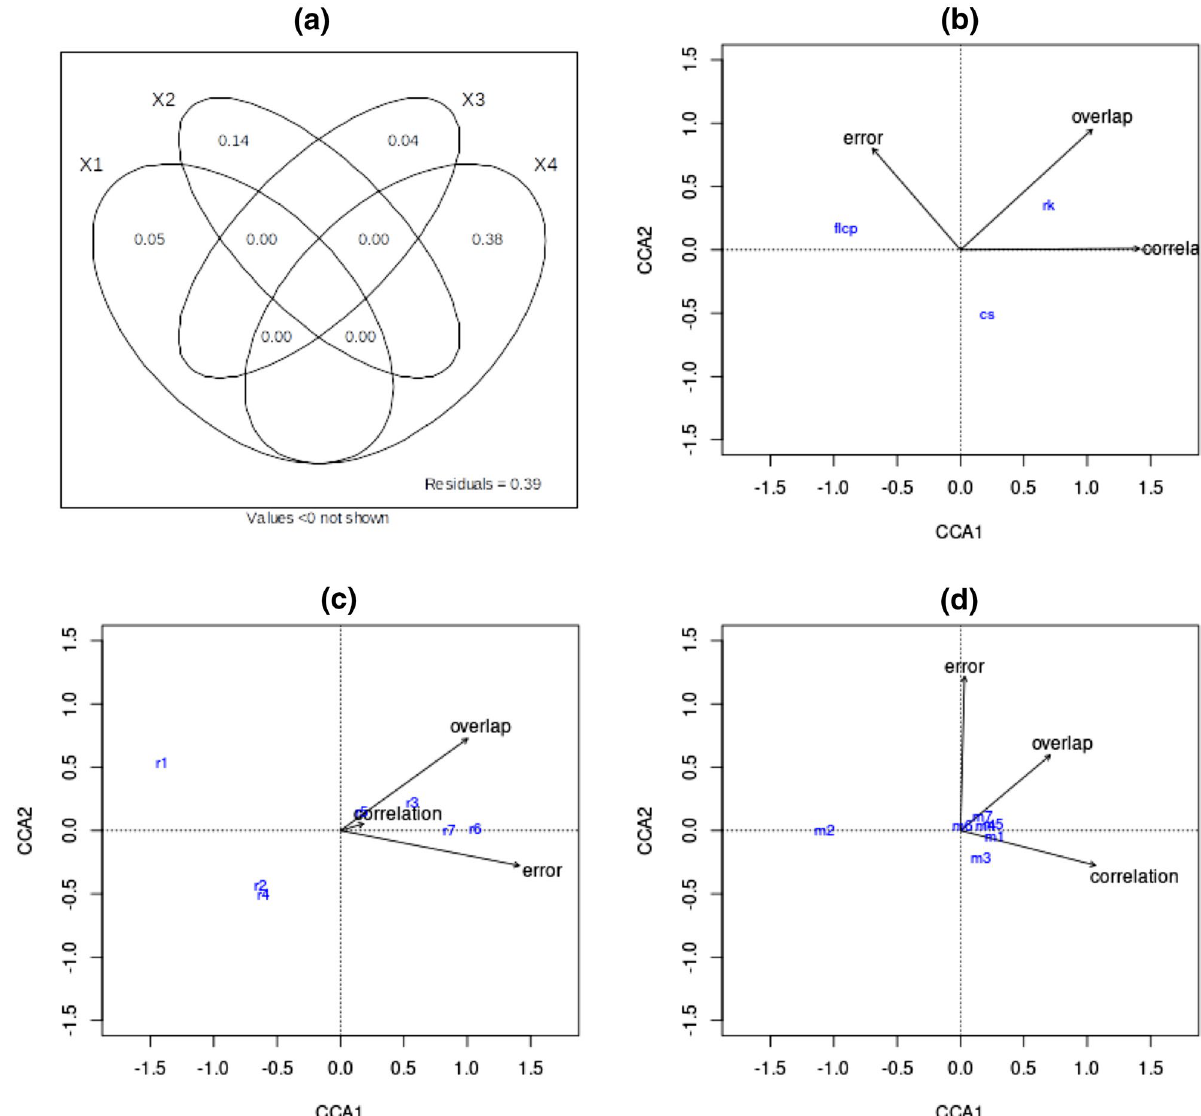
Figure 5. Variance partitioning ( a ) and canonical correspondence analyses ( b – d ) for the first investigation. A key to the CCA figure labels is provided in Supplementary Table S2. The variance partitioning shows model choice (X4) to be the major factor affecting predictive accuracy, more than twice the strength of the effects of spatial complexity of the resistance surface (X2), which in turn is roughly triple that of the mechanism (X1) and the remaining parameters - autocorrelation, scale and scaling function - combined (X3). In ( b ) we see that predictions by resistant kernels overall give the highest correlation and overlap, and those by Circuitscape result in the least error, whereas factorial least-cost paths is seen to be the least accurate with all three statistics. ( c ) shows that higher levels of spatial complexity result in great model error and overlap, with little effect on correlation. ( d ) demonstrates model performance to be much lower when using only the attraction mechanism, without any inclusion of energetic cost or mortality risk.